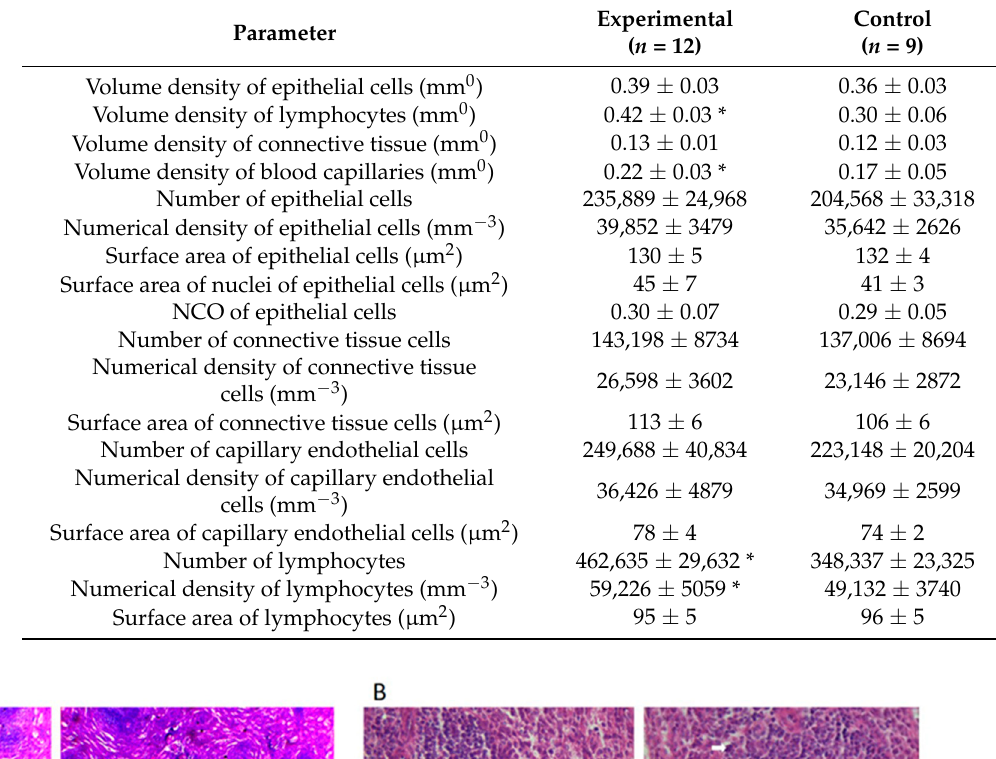
Table 4. Stereological parameters of the spleen of the control group and treated group of rats; values are shown as mean ± SD; Mann–Whitney U -test, * p < 0.05.